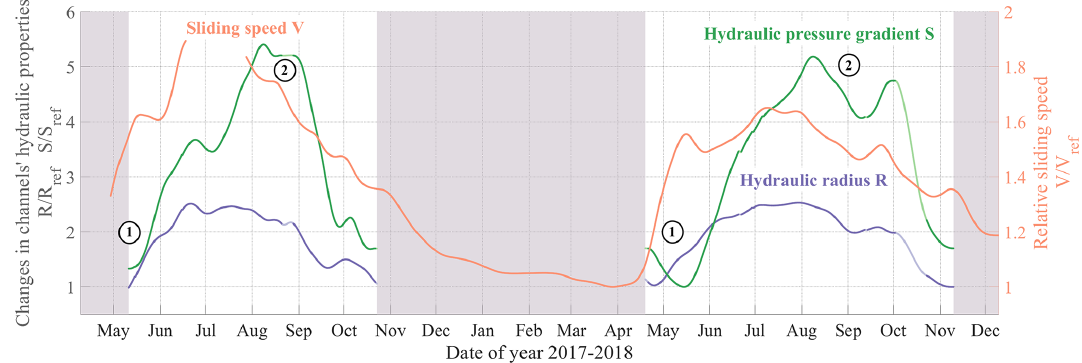
Figure 8. Seasonal evolution of the hydraulic radius and hydraulic pressure gradient as inferred from seismic observations as well as of glacier basal sliding speed as measured in situ. (a) Relative hydraulic pressure gradient S and relative sliding speed (orange line). Red shaded areas represent the winter season. Temporal signals of R and S are calculated using 5d low-pass-filtered time series of Q and P w and are further smoothed applying a 30d low-pass filter. Shaded lines correspond with period with no data and show interpolated values of R and S using a cubic spline interpolation. Reference values for the three variables are taken as their minimum value of the 2 years (i.e. 10 May 2017 for R , 14 May 2018 for S and 28 March 2018 for V ). Circled numbers refer to the three phases described in the main